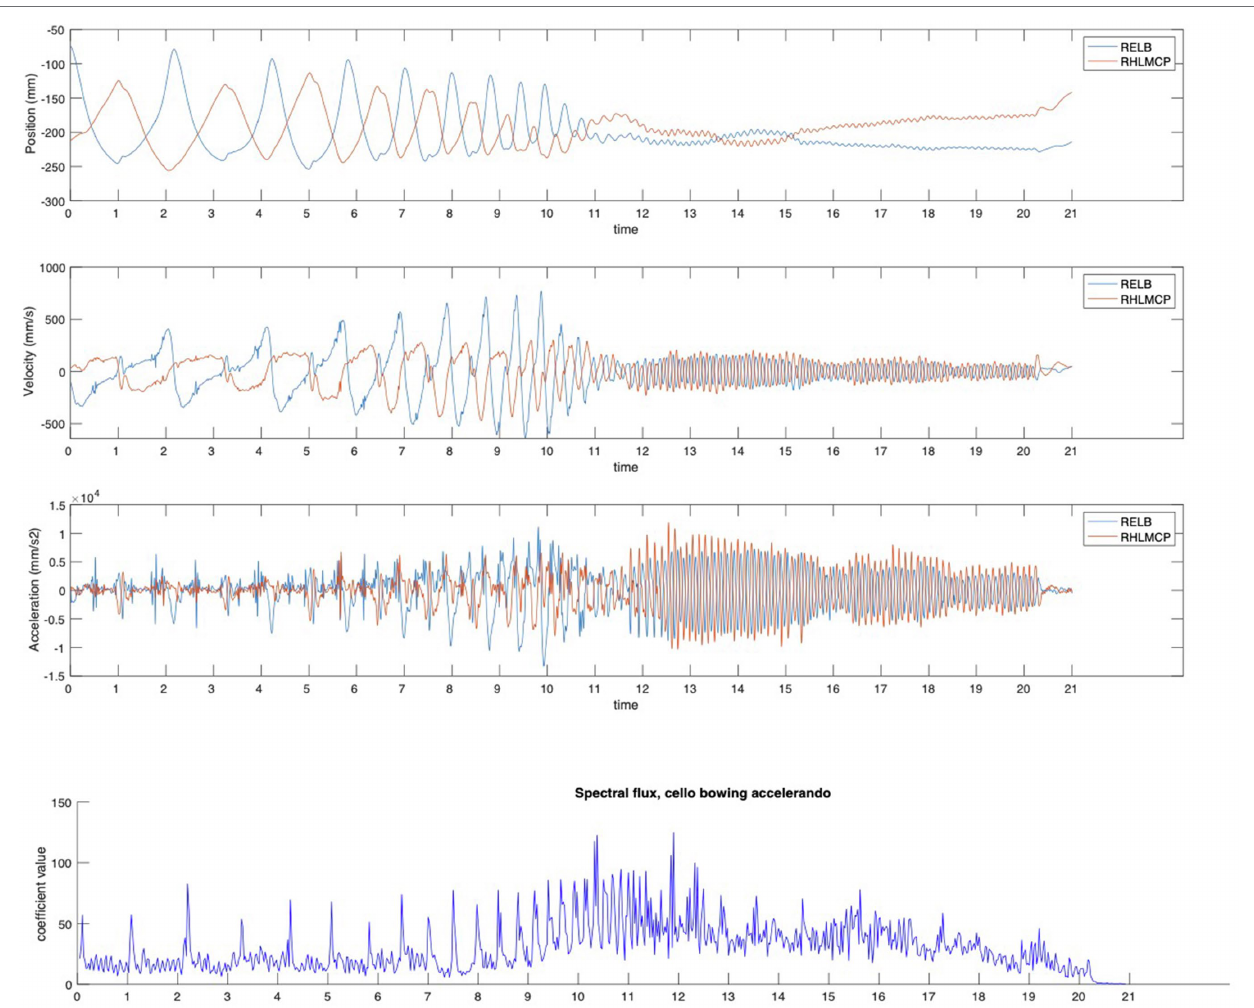
FIGURE 2 | Phase transition in bowing. The figure displays the markers placed on the elbow and wrist (the right hand metacarpophalangeal articulation, next to the left hand little finger) tracing the back-and-forth motion of cello bowing, accelerating from slow to very fast (as fast as in a tremolo), is displaying phase transition of the motion patterns due to the constraints of the high speed, i.e., a change to smaller amplitude motion because large amplitude motion would be impossible at high speeds, eventually ending up in just a shaking of the wrist at the highest speed. Also, note the changes in the spectral flux (rate of change of spectral features) due to an increase in the noise components in turn due to the increase in transients because of the increase in the rate of bow direction changes. The motion trajectories of the two markers were recorded using a Qualisys motion capture system at a frame rate of 300 fps and analyzed with the MoCap Toolbox software (Burger and Toiviainen, 2013), and the spectral flux of the sound of the F#4 was calculated using the MIRtoolbox software (Lartillot and Toiviainen,